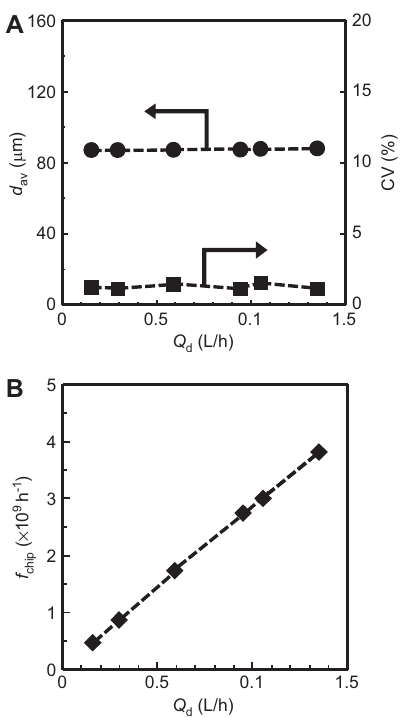
Figure 6 (A) Influence of Q and coefficient of variation (CV) of the O/W emulsions produced using the WMS10 chip. (B) Influence of Q frequency per chip ( f ).